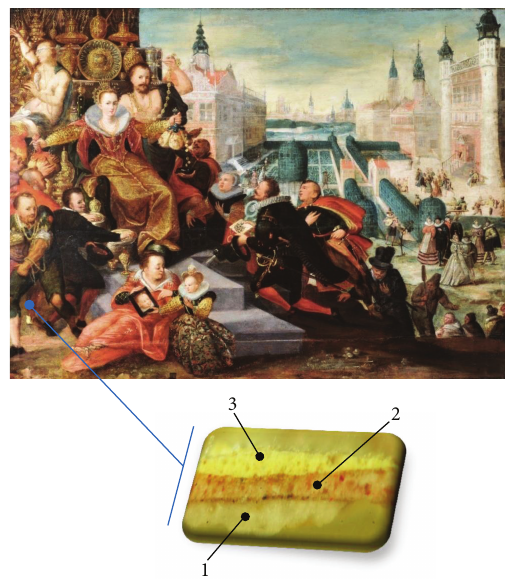
Figure 2: “Allegory of Wealth” (c. 1600) by Anton M¨oller and a cross-section of sample (AW): AW.1—white ground layer/under- painting, AW.2—red painting layer, and AW.3—yellow painting